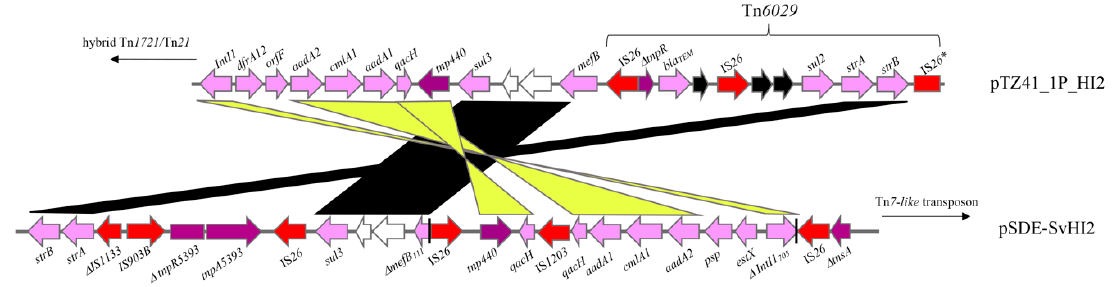
Figure 3. Pairwise alignment of the resistance locus in pTZ41_1P_HI2 and pSDE-SvHI2, highlighting regions of homology and differences.